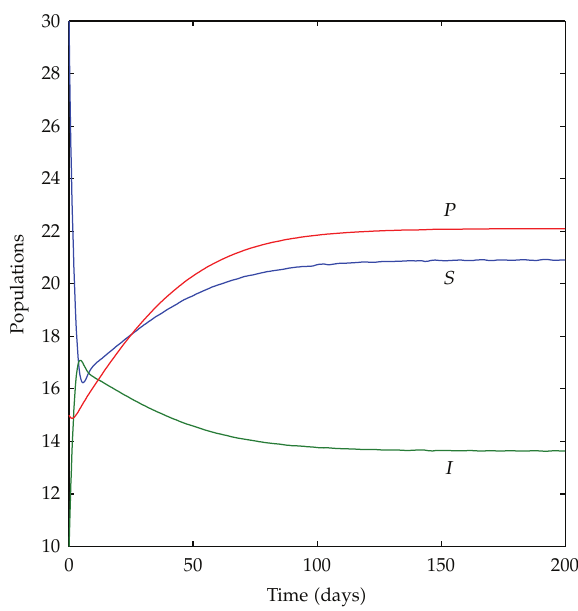
Figure 1: Stable coexistence of prey and predator for τ (cid:5) 0. Parameter values are given in the